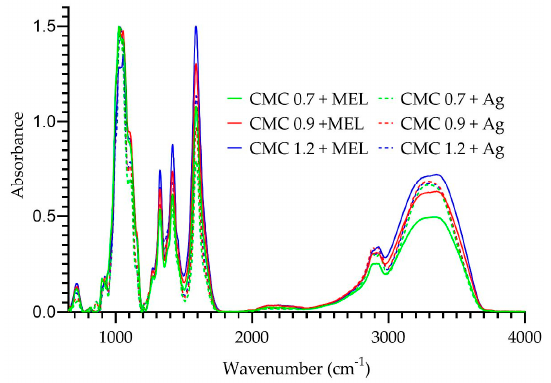
Figure 3. FT-IR spectra of melanin-modified and AgNP-modified CMC films.